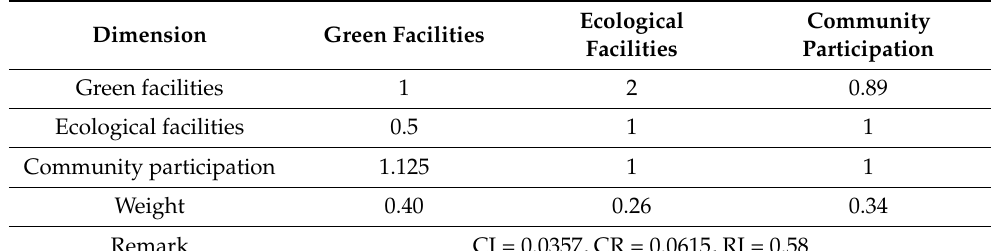
Table 2. Pairwise comparison of relative weights of three dimensions at level 1.